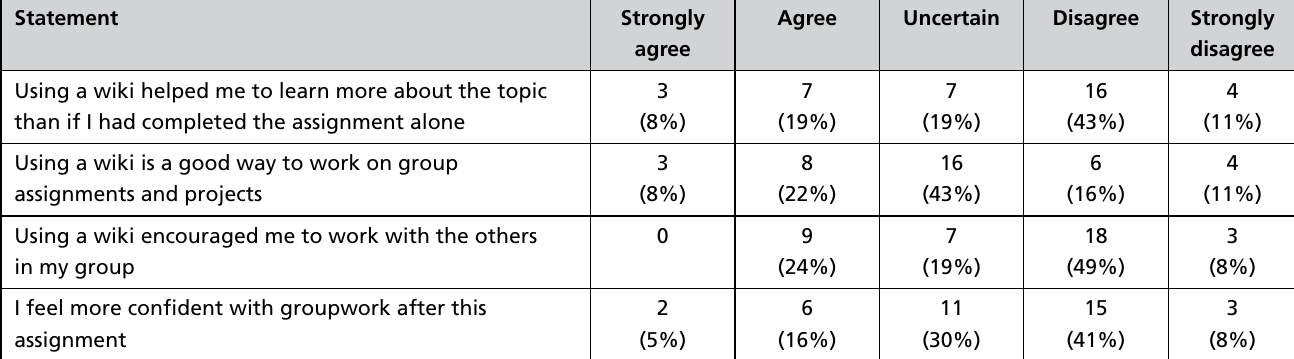
Table 2: Respondents’ perceptions on the use of a wiki to facilitate collaborative groupwork (N=37) Statement